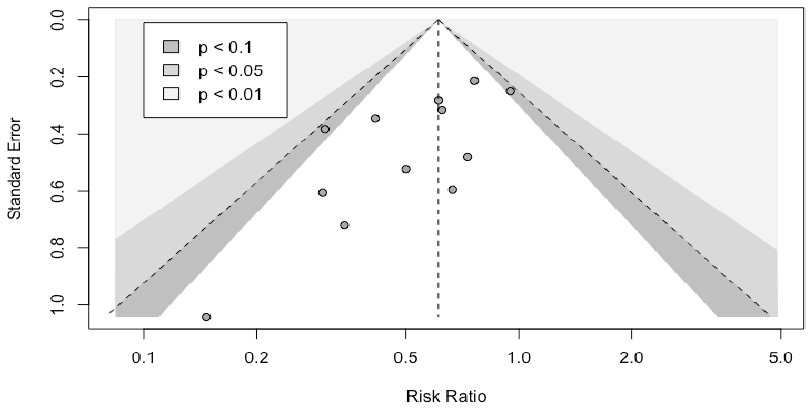
Figure 7. Funnel plot. Outcome = overall infectious complications.